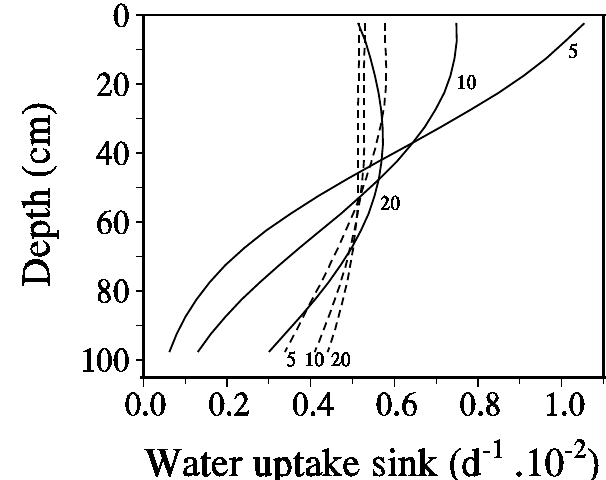
Fig. 3. Water uptake sink during dry-down from saturation, simu- lated with Eqs. (1) to (4) after 5, 10 and 20 days, assuming M 0 to be given by Eq. (8) (dashed lines) or Eq. (17) (solid lines), for the case of moderate compensation ( R L( eff ) = 10cm cm − 2 ) . Remaining pa- rameter values are as given in Table 1, initial/boundary conditions in the